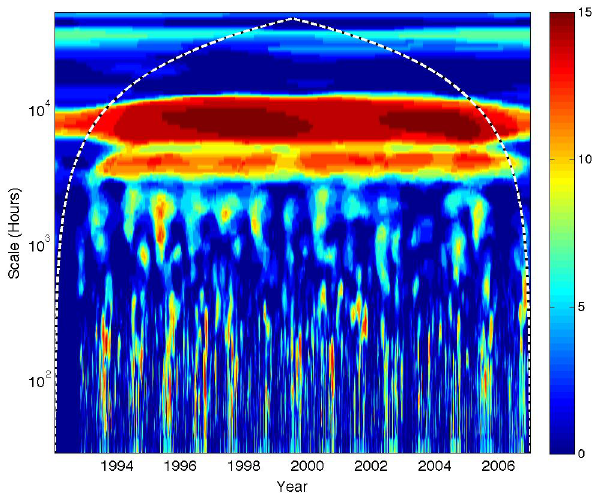
Fig. 4. The sum of significant wavelet coherence coefficients for net ecosystem exchange (NEE) observations at the Harvard Forest (US- Ha1) and simulations by 15 ecosystem models (Table 2). This figure represents the sum of the subplots of Fig. 3 including the other mod- els that were run at US-Ha1 listed in Dietze et al. (2011). A value of 15 indicates that all 15 models explored here are significantly related to NEE